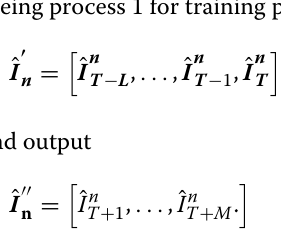
seeing process 1 for training process of AI model, input